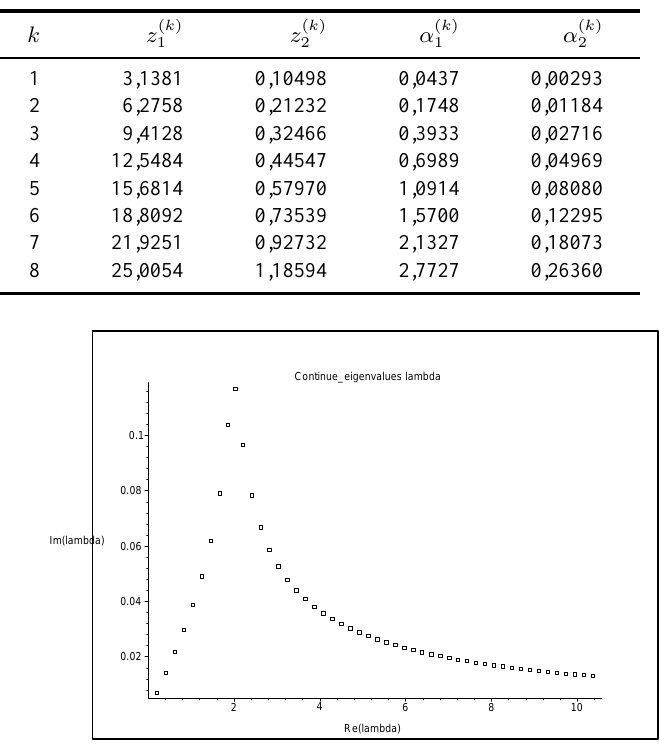
Table 1. The roots of equation (2.6) and values of (cid:11) ( k ) :